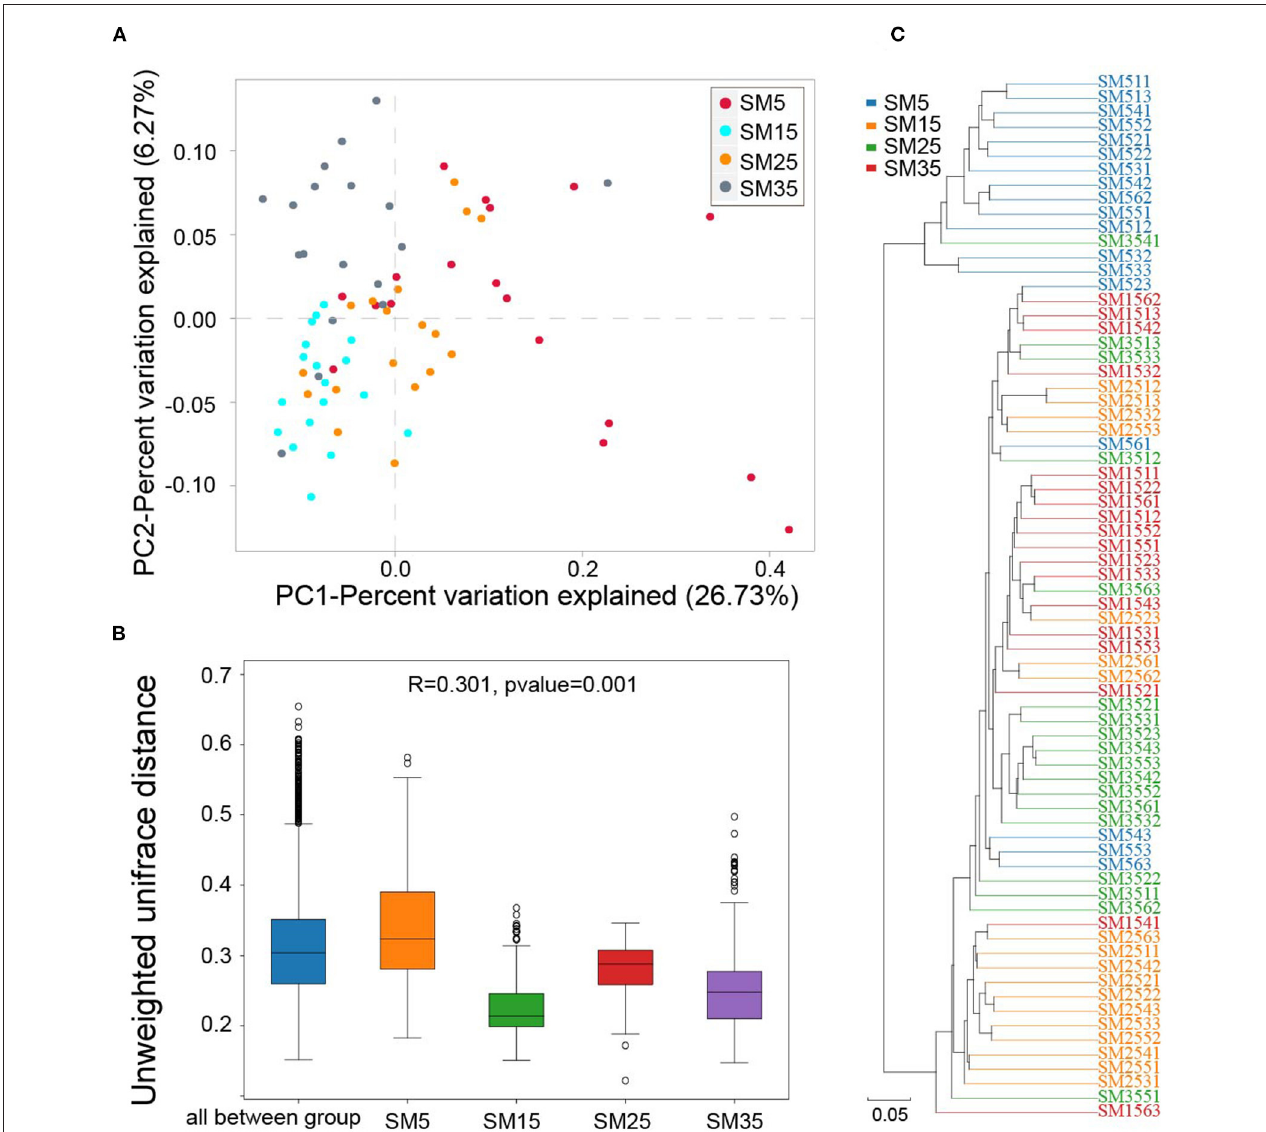
FIGURE 2 | Beta diversity in the phyllosphere bacterial community of Chinese fir. (A) Scatterplot of axes 1 and 2 from a PCoA based on unweighted UniFrac dissimilarity matrix; (B) unweighted ANOSIM; (C) UPGMA dendrogram. SM5, SM15, SM25, and SM35 represent stand ages of 5, 15, 25, and 35 years,